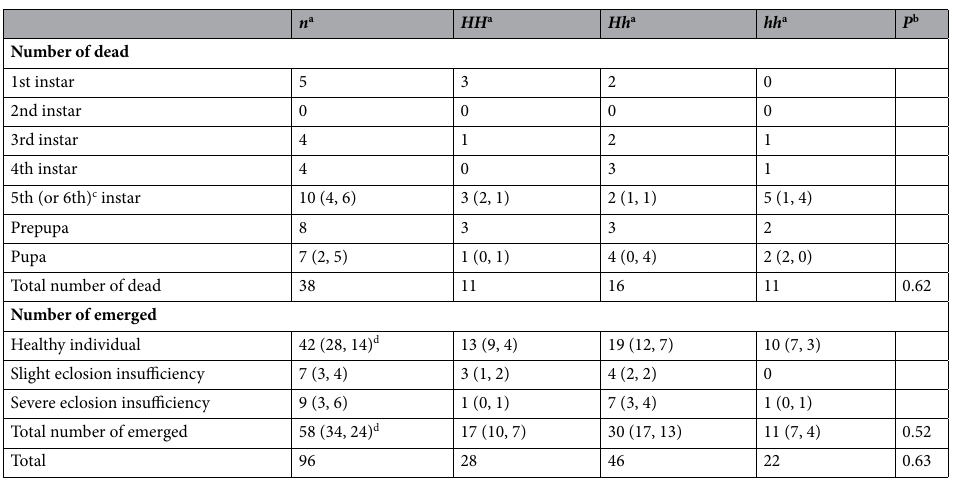
Table 1. Numbers and doublesex genotypes of individuals reared and emerged as adults in the rearing experiment with Papilio polytes . a The numbers in parentheses are the number of males and females, respectively. b P -values of the chi-square test for the goodness of fit with the expected segregation ratio